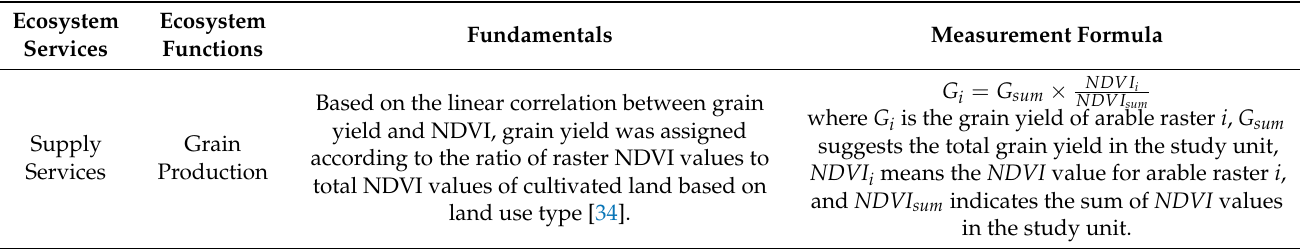
Table 2. Principles and methods for assessing the ecosystem service functions of each ecosystem in the central Yunnan urban